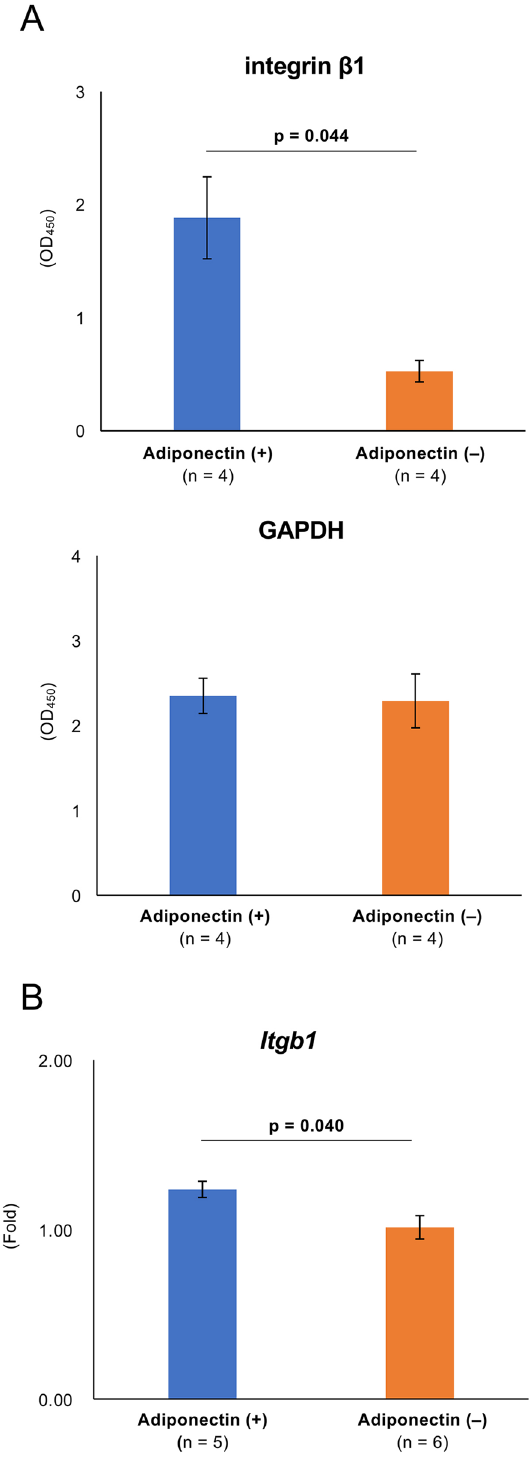
Figure 5. Expression of adhesion factors in islets. ( A ) Expression of integrin β1 (upper) and GAPDH (lower) on islets treated with adiponectin (adiponectin (+), blue) and without adiponectin (adiponectin (−), orange). GAPDH was used as an internal control. ( B ) Itgb1 expression in islets quantified by qRT-PCR. The results were normalized to the β-actin gene and are presented as the fold difference over the detectable Ct value, which was calculated using the ΔΔCt method. Adiponectin (+) (blue), adiponectin (−) (orange). Data are presented as means ± standard error of the mean. A p -value < 0.05 was considered statistically